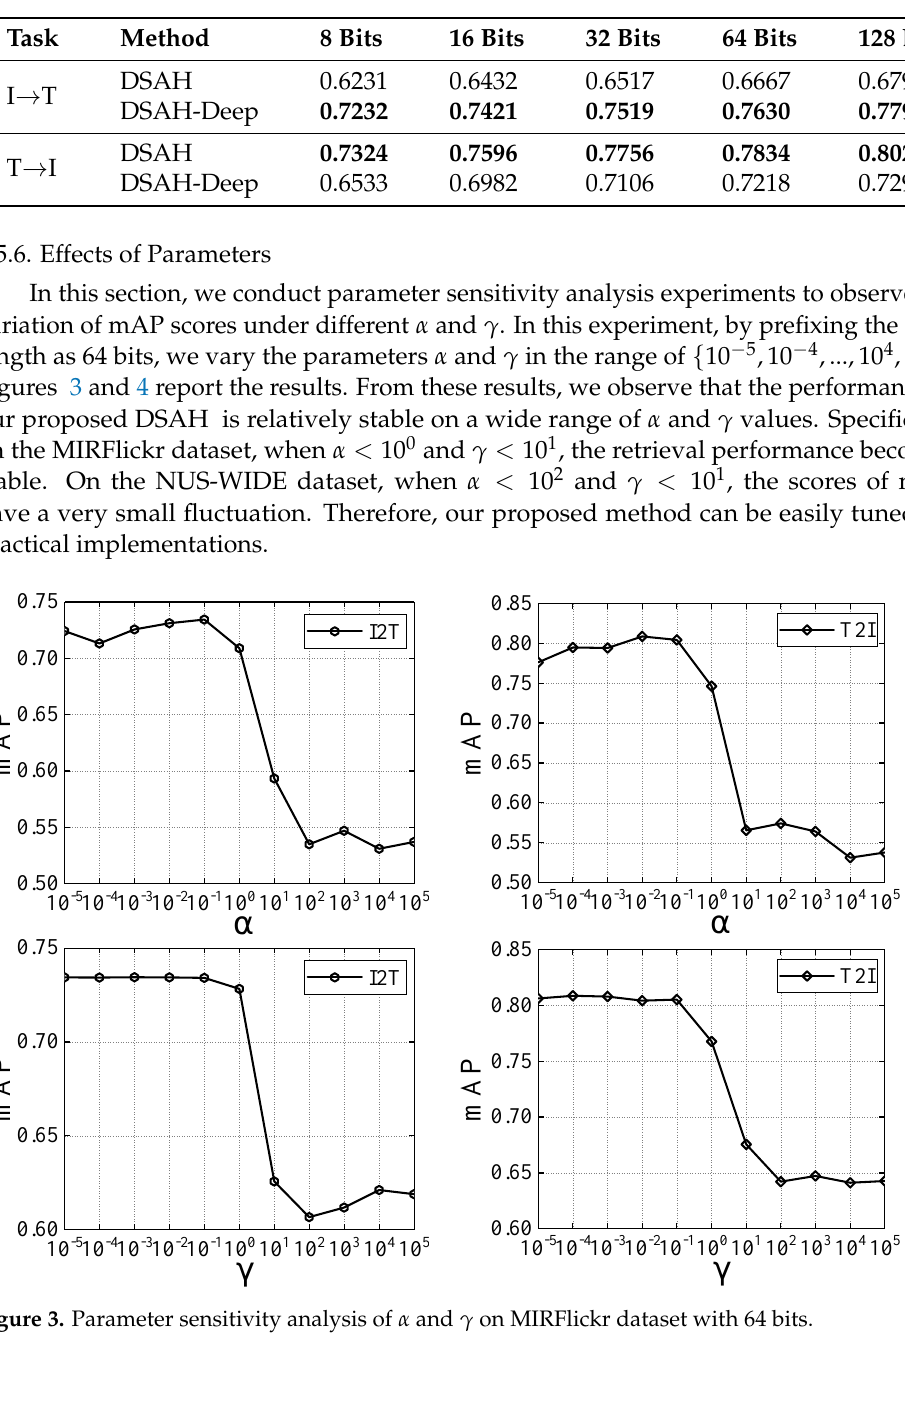
Table 7. mAP scores on NUS-WIDE dataset using deep and shallow representations of DSAH.